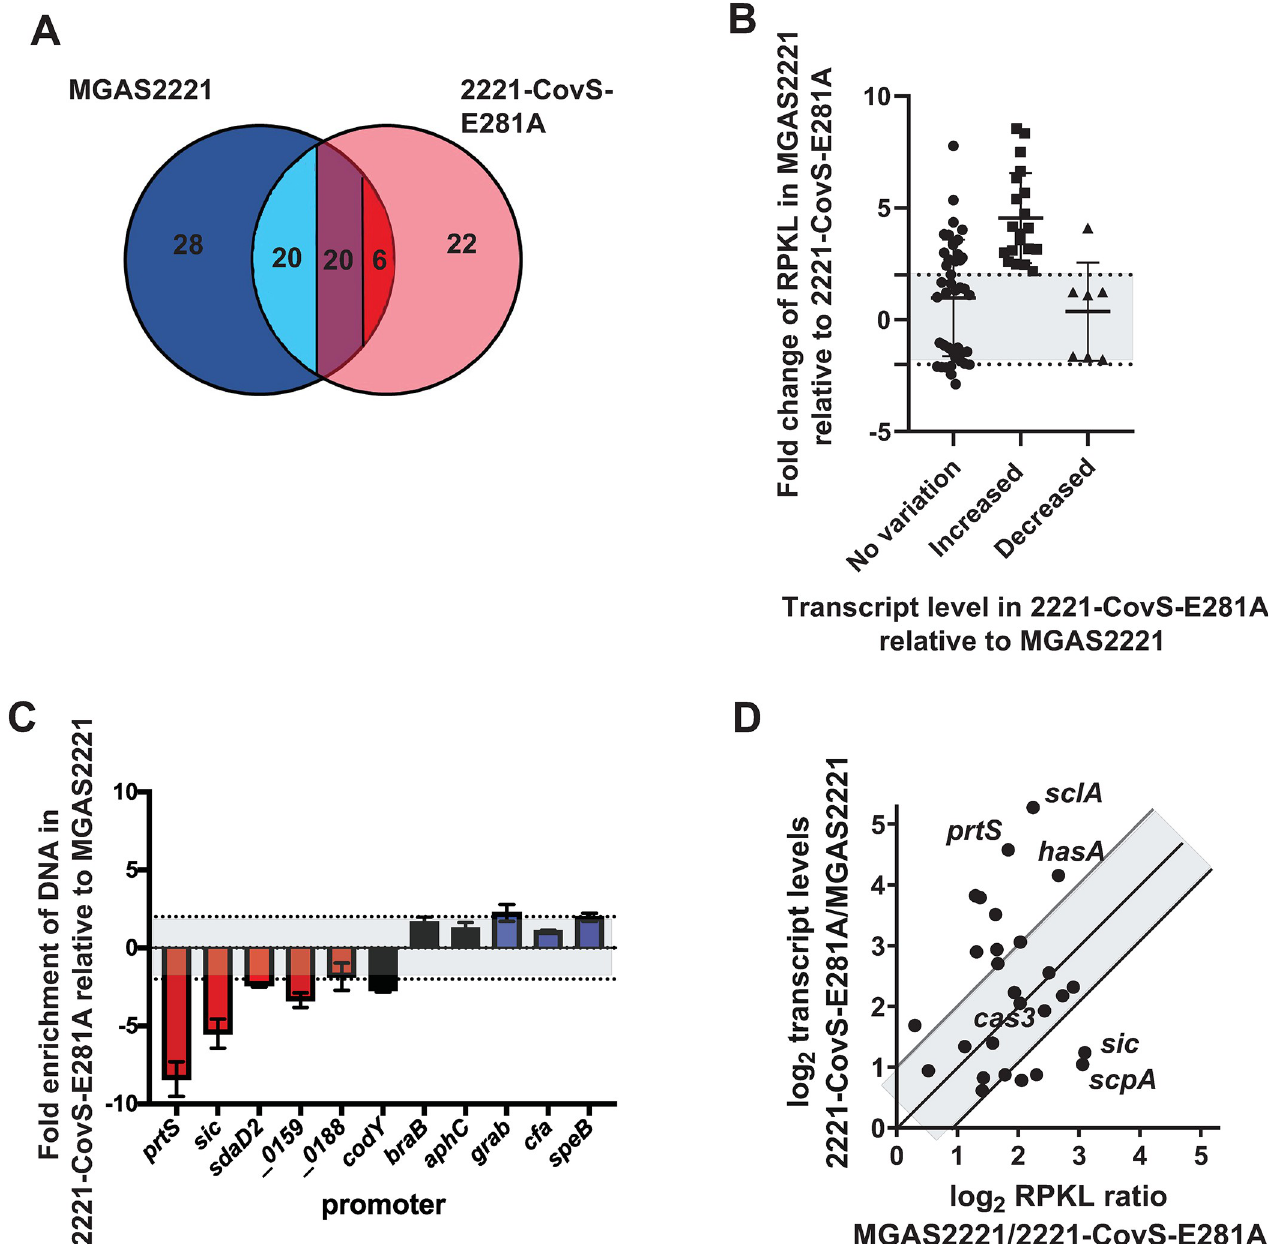
Fig 7. Influence of CovR phosphorylation on DNA binding. ( A ) Venn diagram depicting number of binding loci in strains MGAS2221 (blue) and 2221-CovS-E281A (pink). Note that binding sites both strains had in common can be further divided by relative RPKL ratios ( > 2-fold higher RPKL in MGAS2221 (light blue), no significant difference (purple), and > 2-fold higher RPKL in 2221-CovS-E281A (red). ( B ) RPKL ratio of MGAS2221/ 2221-CovS-E281A for particular genes stratified by � 2-fold variation in transcript level variation (transcript level data from [30]). Only genes with CovR binding loci in promoter regions were included. Gray area between dotted lines indicates no significant ( < 2-fold) changes in RPKL ratio. ( C ) SYBR qPCR analysis showing CovR-mediated DNA enrichment of selected promoters in strain 2221-CovS-E281A relative to MGAS2221. Bars are colored in red for CovR~P repressed promoters, in black for promoters not regulated by CovR~P, and in blue for CovR~P activated promoters. Data shown are mean ± standard deviation of at least two biological samples measured in duplicate. Gray area indicates area of < 2-fold differences in enrichment. (D) Correlation of change in transcript levels and change in RPKL values between strains MGAS2221 and 2221-CovS-E281A. Selected genes mentioned in the text are labeled. Greyed area indicates RPKL/transcript level variation ratios between 0.5 and 2 with middle line on 1.